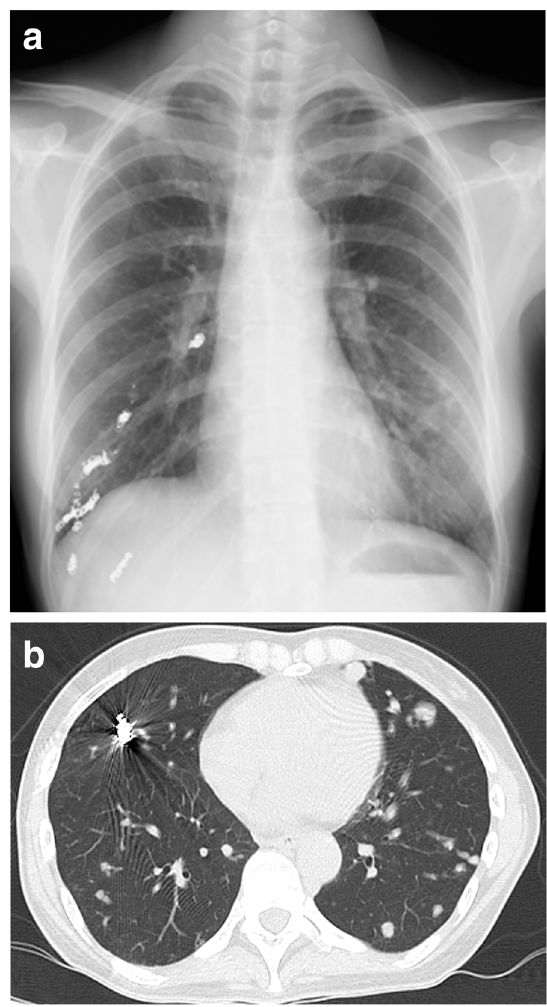
Fig. 1 a Chest radiograph. The chest radiograph shows preoperative coil embolization of the pulmonary arteriovenous malformations on the right lung. b Computed tomography of the chest. The computed tomography of the chest shows bilateral pulmonary arteriovenous